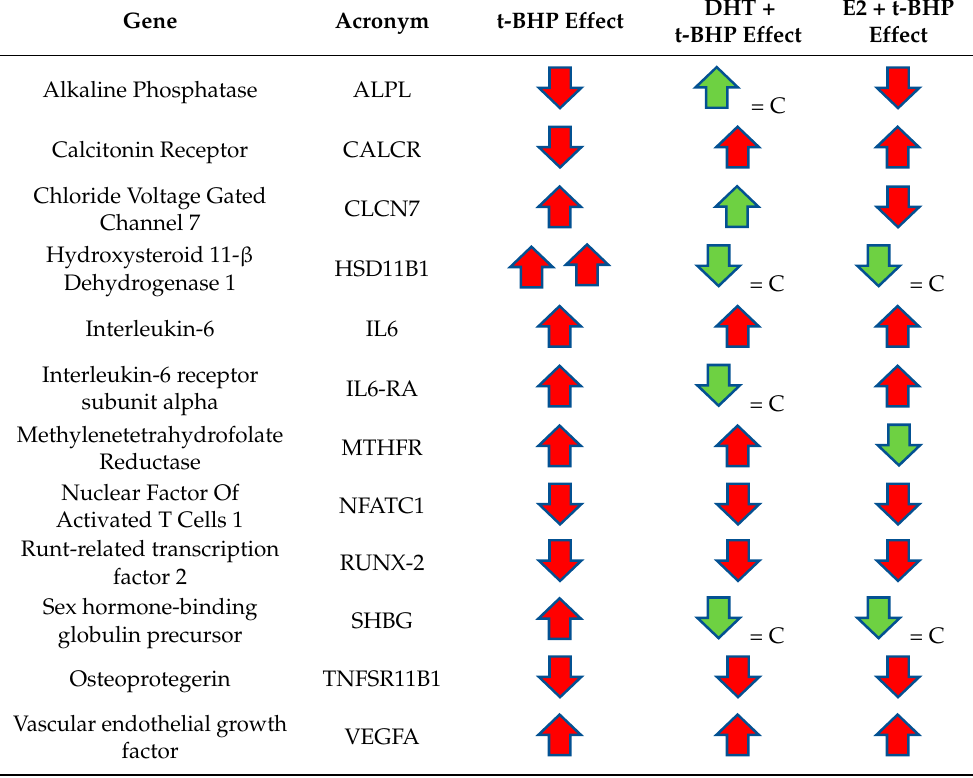
Table 1. Transcriptomic profile affected by t-BHP exposure. Effects of t-BHP in gene expression of 7-day-differentiated cells. The analysis is focused on osteoporosis pathways. The effects of E2 and DHT pre-treatment are also shown. The red arrows indicate the t-BHP effect, the green arrows indicate the recovery of gene expression induced by DHT or E2, C indicates the control group.